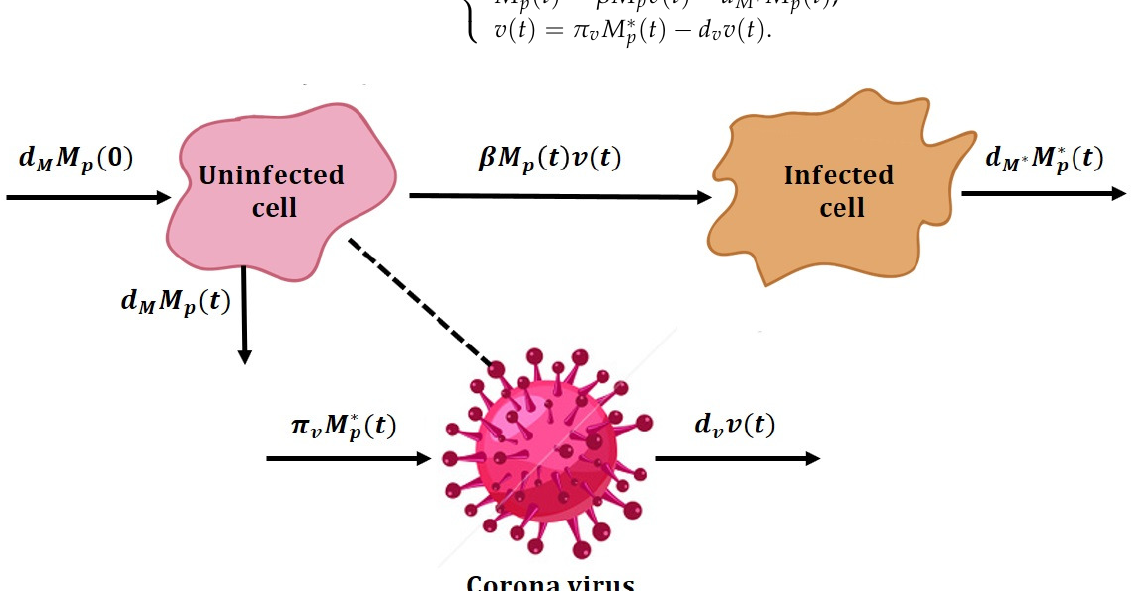
Figure 1. Schematic diagram of the model